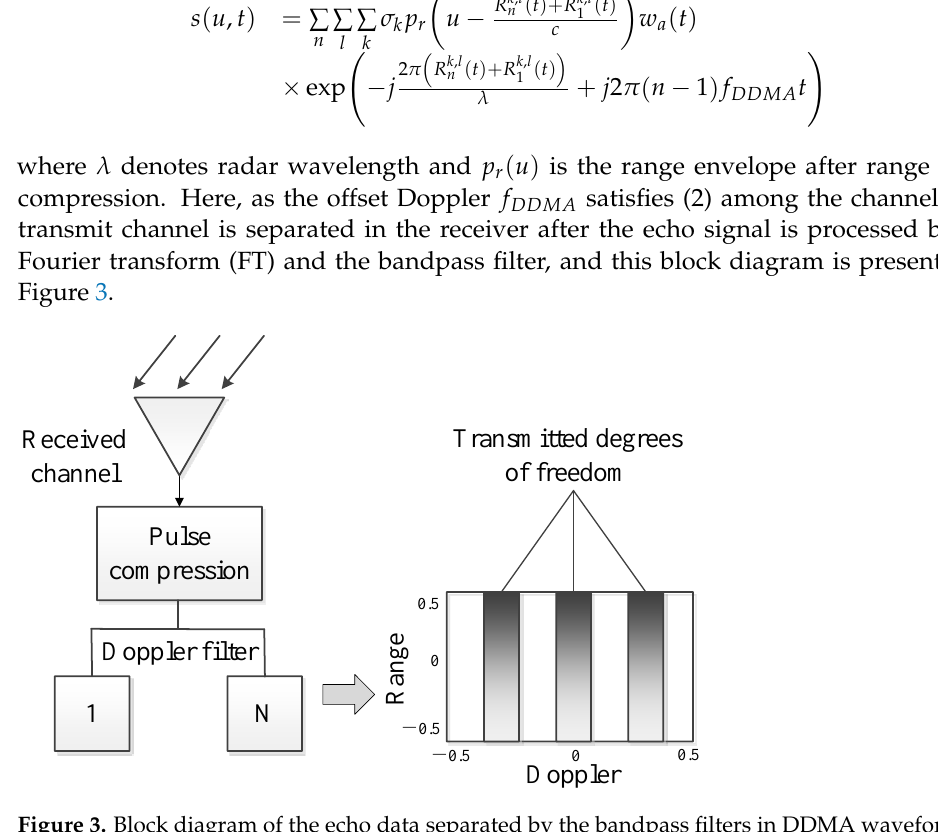
Figure 3. Block diagram of the echo data separated by the bandpass filters in DDMA waveforms.